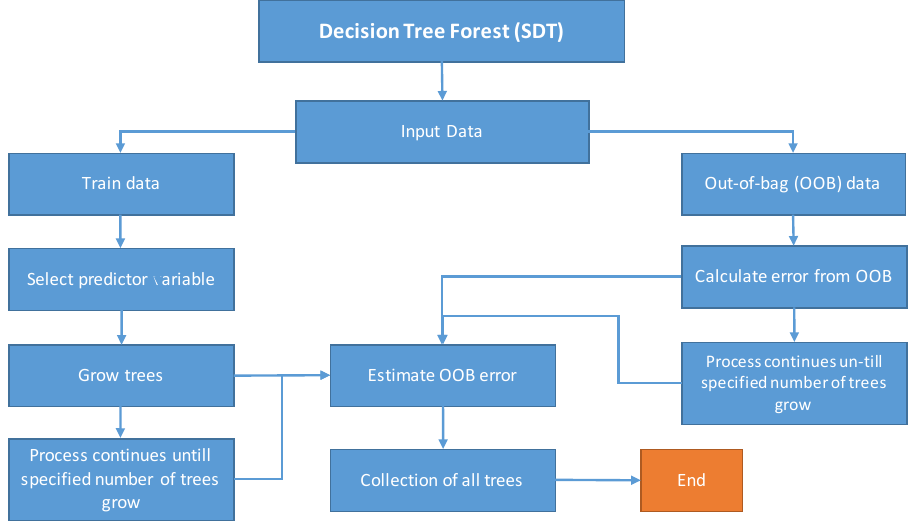
Figure 5. Flow chart of decision tree forest (DTF) (reproduced from Raza et al. [37]).